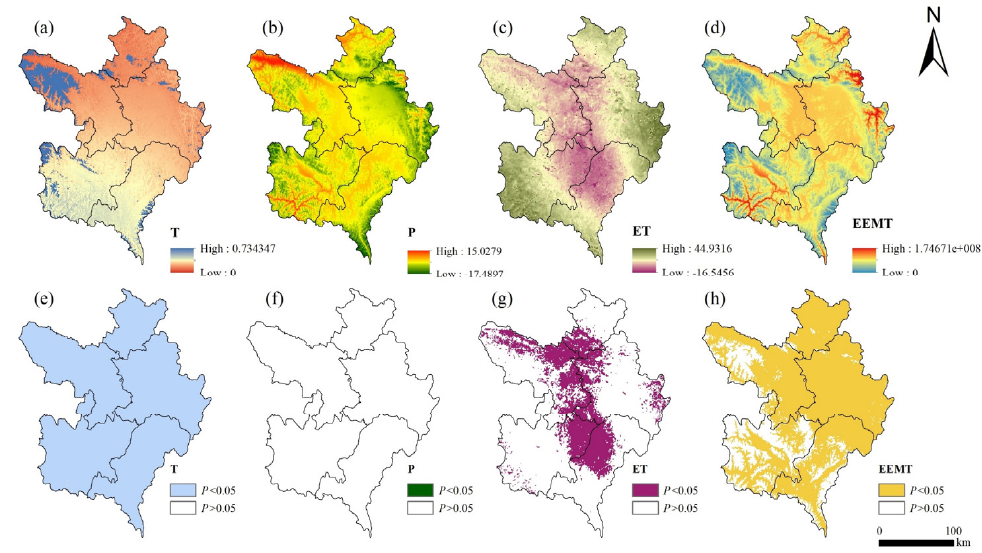
Figure 4. Spatial distribution of change trend values ( a – d ) and significance ( p < 0.05) ( e – h ) of temperature (T), precipitation (P), evapotranspiration (ET), and effective energy and mass transfer (EEMT) of